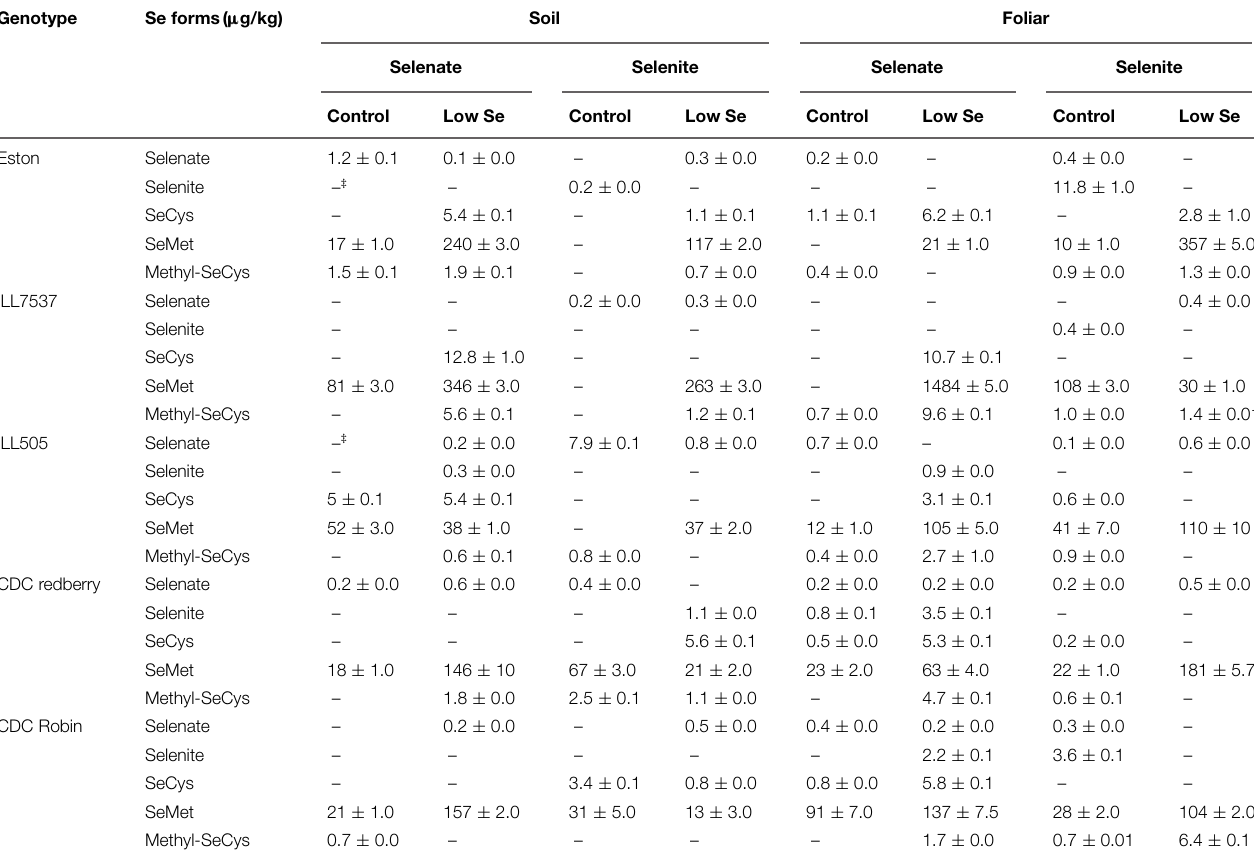
TABLE 3 | Effect of soil and foliar application of selenate and selenite on Se speciation of lentils grown under greenhouse